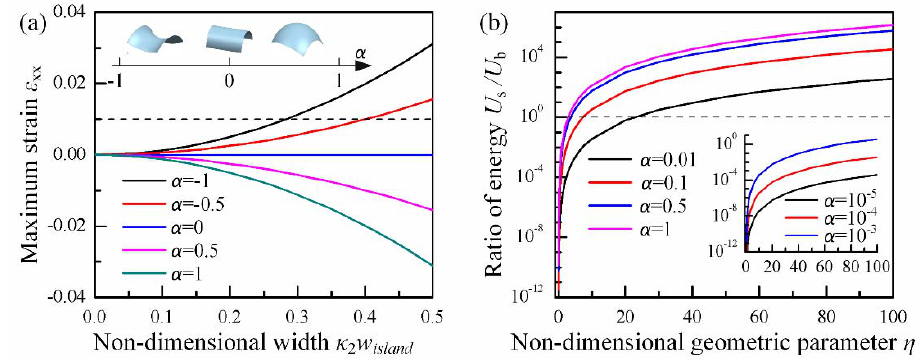
Figure 2. Strain and strain energy in the island during conformal contact: ( a ) maximum strain in island with non ‐ dimensional width κ 2 w island at κ 2 t island = 10 − 6 ; ( b ) the ratio of stretching strain energy to bending strain energy with non ‐ dimensional parameter η .